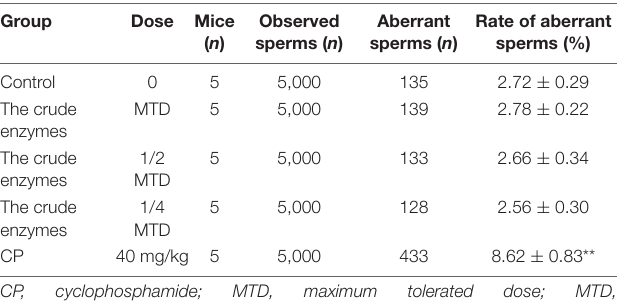
TABLE 7 | The results of sperm aberration test.